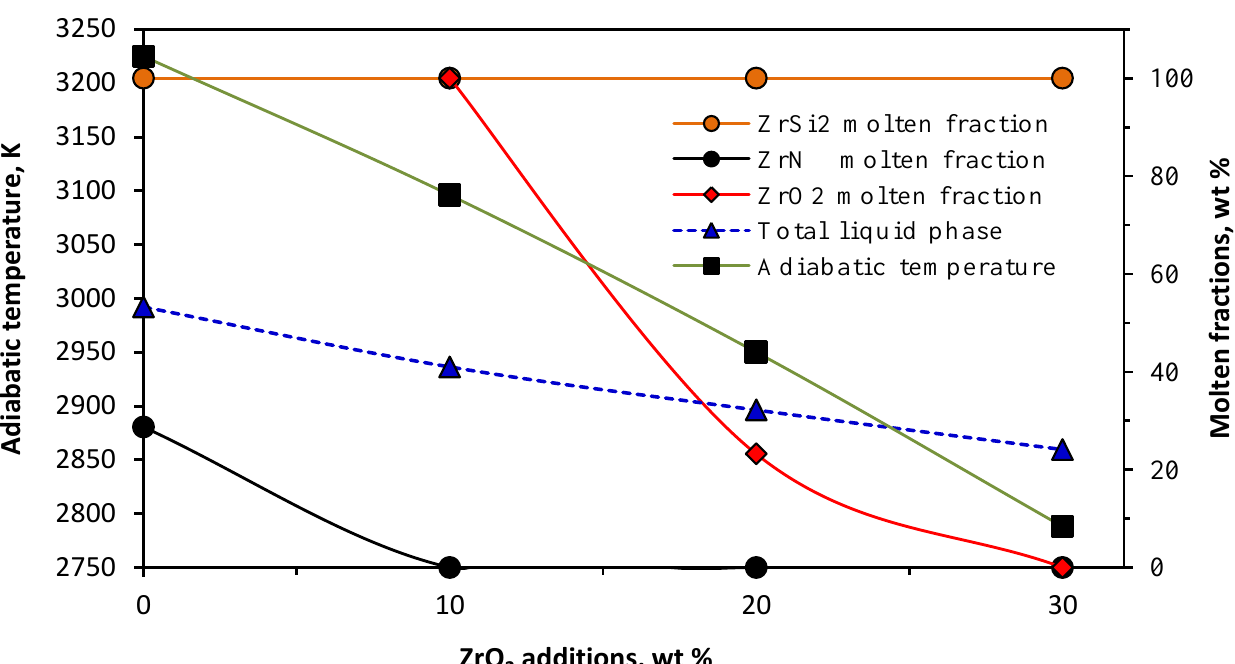
Figure 1. Effect of ZrO 2 additions on the adiabatic temperature, molten fractions and total liquid phase at the ignition temperature (1241 K).